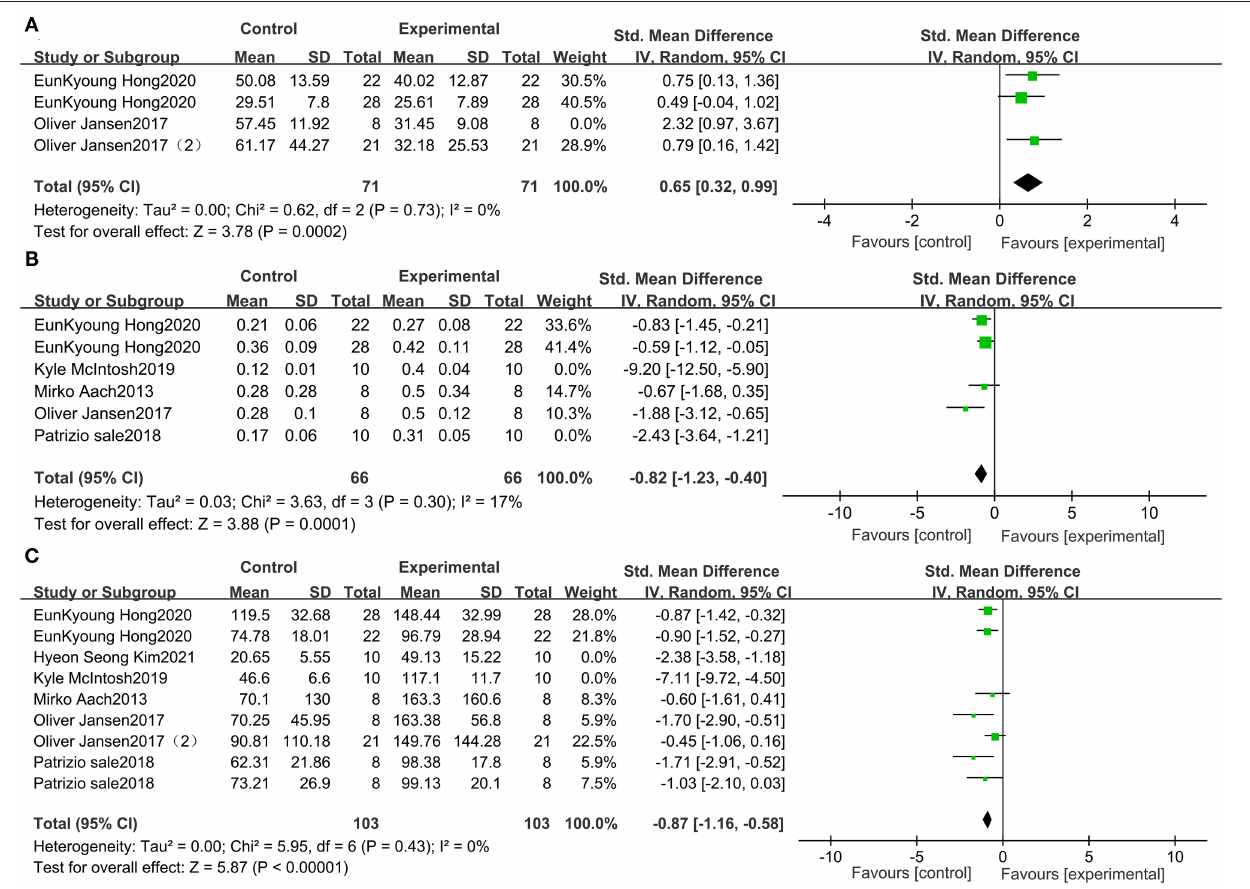
FIGURE 5 | Forest plots for the sensitive analysis. Change from baseline in the distance traveled in the 10-MWT (A) , the speed traveled in the 10-MWT (B) , and the distance traveled in the 6 MWT (C) .